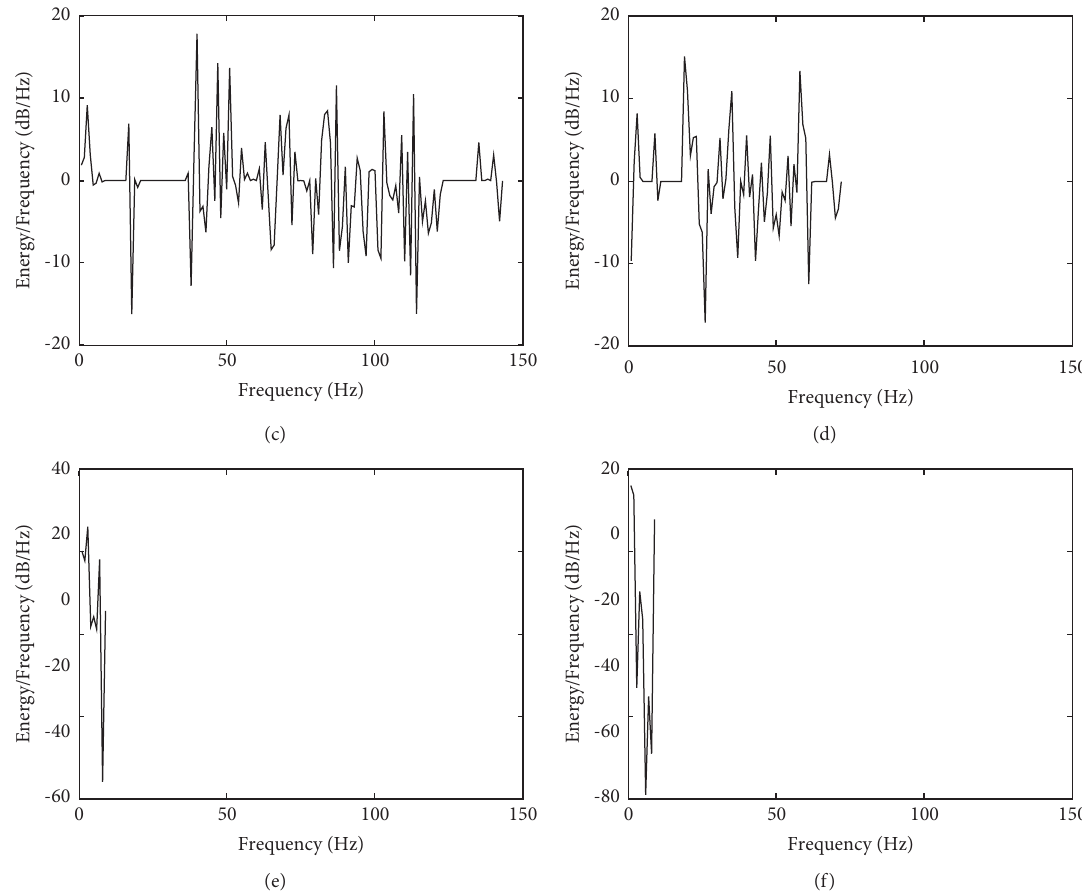
Figure 8: Wavelet power of steering wheel angel rate in 70m median width entrance by-pass.